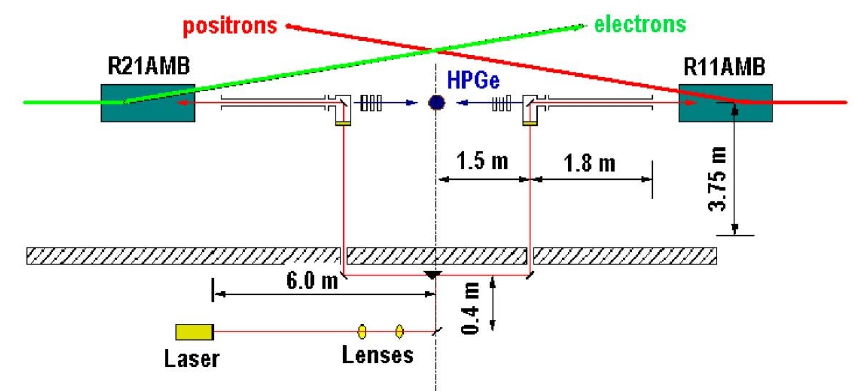
Figure 1: Simplified schematic of BEMS. The positron and electron beams are in- dicated. R1IAMB and R2IAMB are accelerator magnets, and the HPGe detector is represented by the dot at the center. The shielding wall of the beam tunnel is shown cross-hatched, and the laser is located out-side the